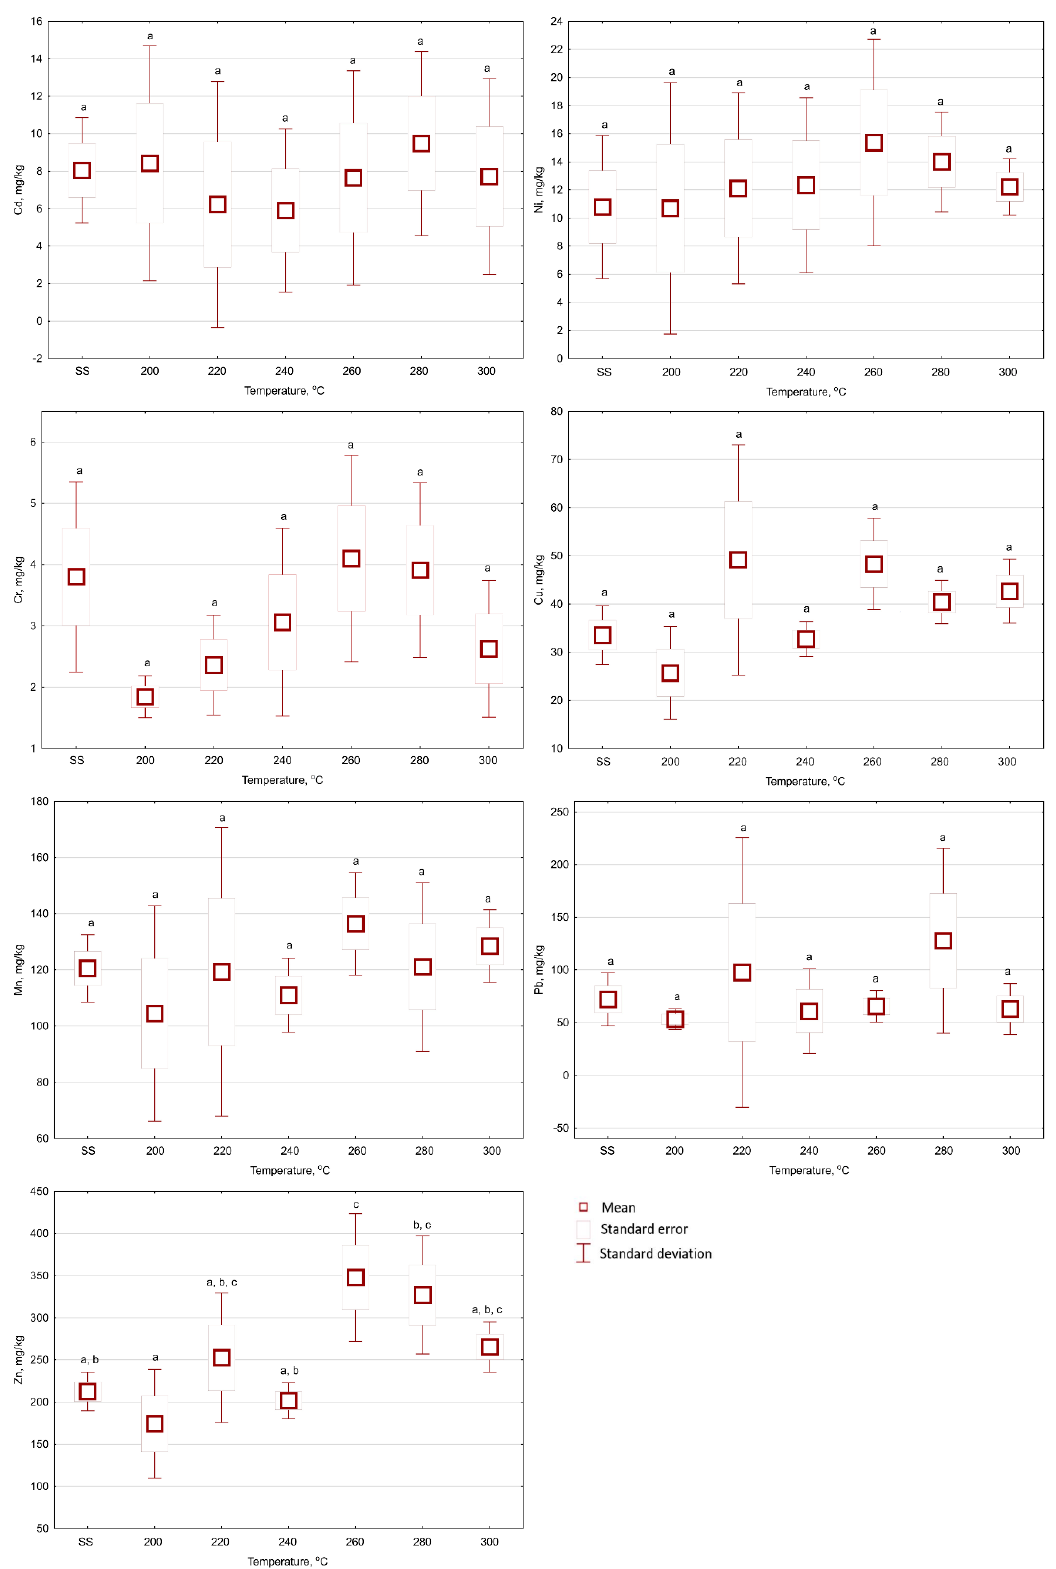
Figure 3. The influences of temperature on Cd, Ni, Cu, Mn, Pb, Zn, and Cr contents in biochars produced with 40 min of retention time under 200–300 °C temperatures (SS—raw sewage sludge). Letters indicate the statistically significant ( p < 0.05) differences between mean values.